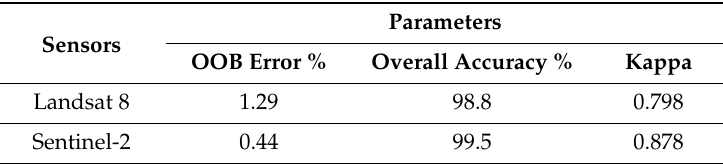
Table 1. Statistical evaluation of Random Forest (RF) performance and map accuracy assessment. The overall accuracy and kappa were obtained from the testing data and the out-of-bag error (OOB) generated by RF of each of the model obtained from training data.